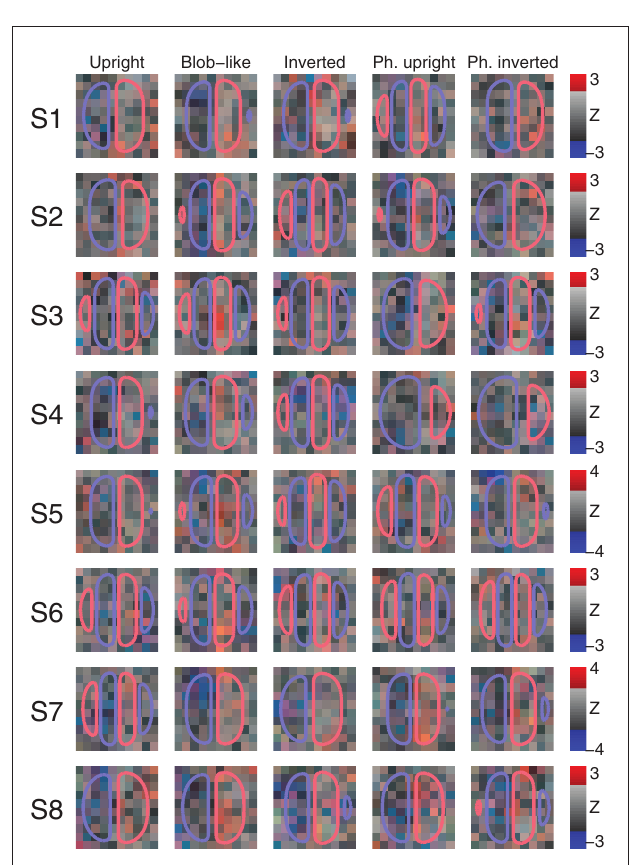
Figure A1 | Perceptual filters for individual observers (S1–S8). First column shows filters for the upright condition, second column for the blob-like condition, third column for the inverted condition, fourth column for upright phase-only condition, fifth column for inverted phase-only condition. Each filter is plotted to the conventions of Figure